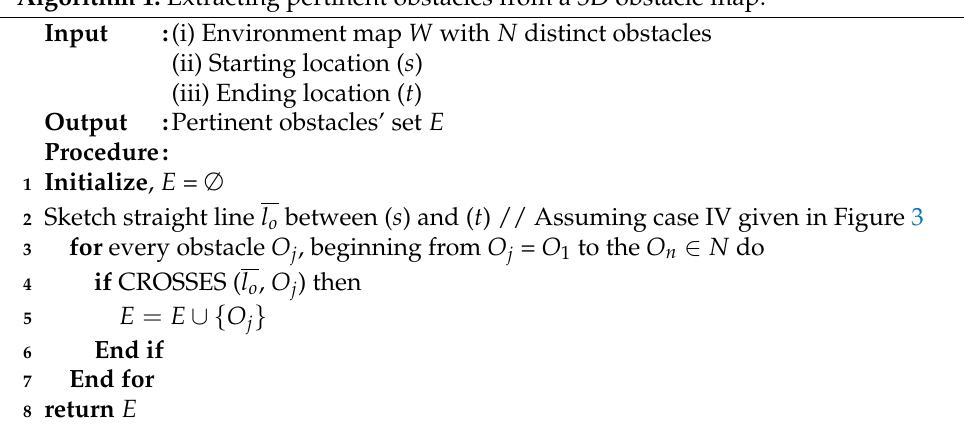
Figure 4. Overview of transforming a full 3D map W into a constrained polygonal space ( S 3 .